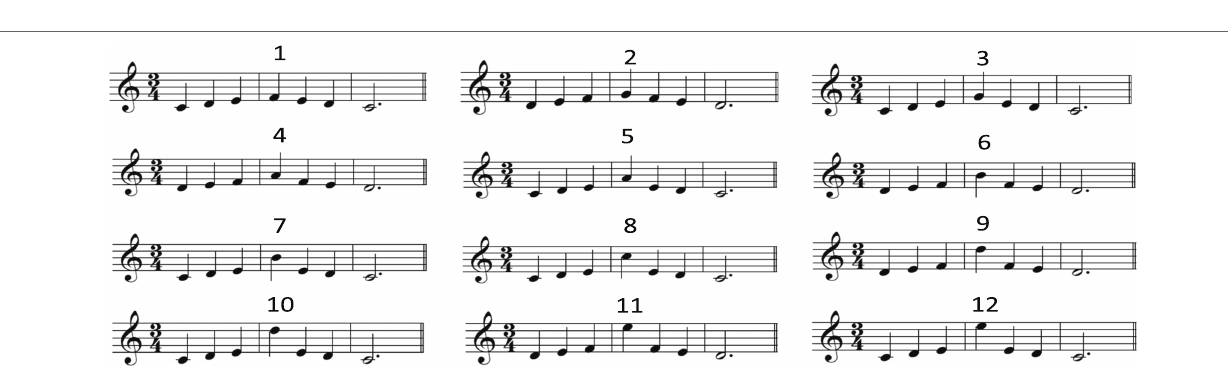
FIGURE 5 | The 12 short excerpts composed as the music stimuli. Each excerpt corresponds to a different interval size between the third and fourth note (1 = 1 semitone, 2 = 2 semitones … 12 = 12